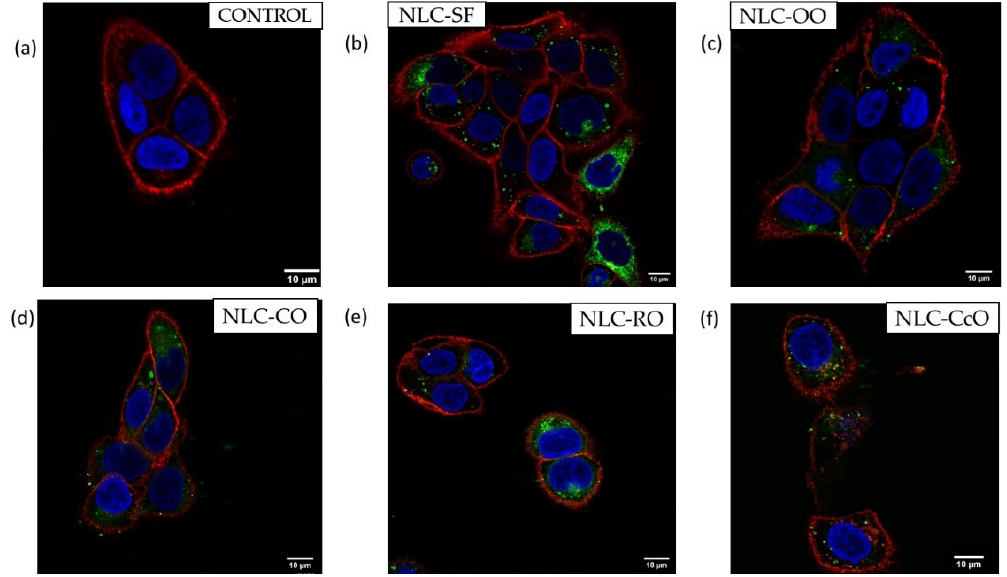
Figure 9. Cellular internalization of five different NLCs at dilution D = 50 after 3 h of incubation. ( a ) HaCaT cells; ( b ) NLC-SF; ( c ) NLC-OV, ( d ) NLC-CO, ( e ) NLC-CS and ( f ) NLC-CC.